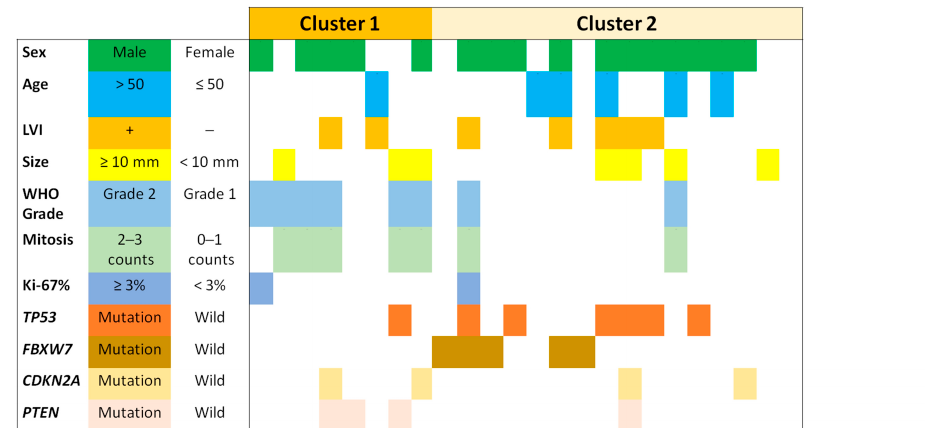
Figure 1. Hierarchical clustering map of differentially regulated miRNAs between FBXW7 wild-type and mutated rectal neuroendocrine tumors. Each row represents one miRNA, and each column represents one sample. Red and light yellow indicate the high expression level above the mean and the low expression level below the mean.